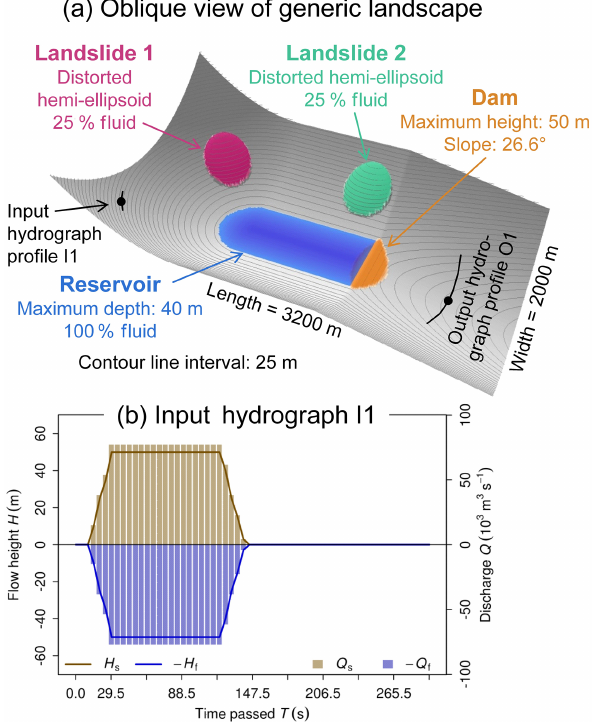
Figure 5. Generic landscape used for Experiment 1A–C. (a) Oblique view illustrating the topography and elements of the landscape. (b) Input hydrograph I1 employed for Experiment